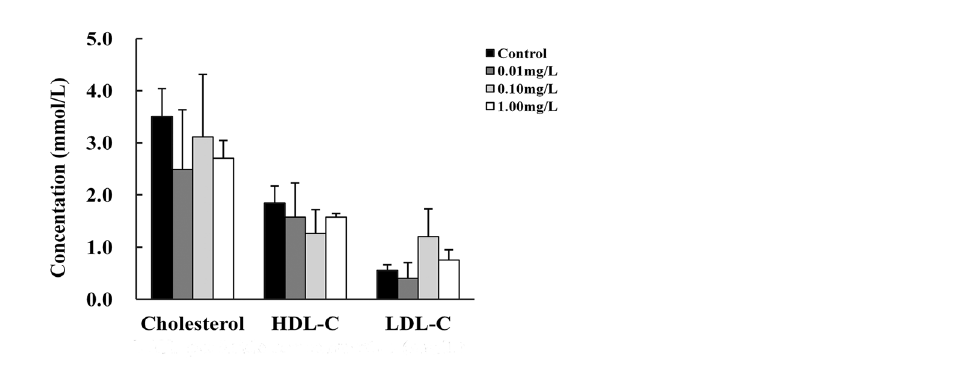
Figure 2. Effects of MCP pesticide on total cholesterol, HDL-C, and LDL-C content in plasma of male goldfish ( Carassius auratus